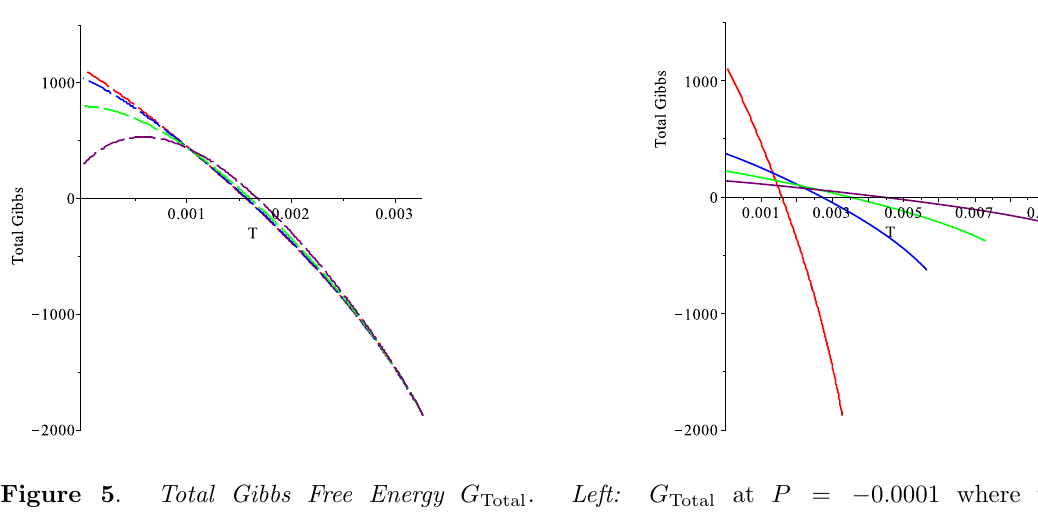
Figure 5 . Total Gibbs Free Energy G Total . Left: G Total at P = (cid:0) 0 : 0001 where the f red; blue; green; purple g curves correspond to the potential (cid:8) = f 0 : 1 ; 1 ; 2 ; 3 g respectively . Right: G Total at (cid:8) = 0 : 1 where the f red; blue; green; purple g curves correspond to the pressure P = f(cid:0) 0 : 0001 ; (cid:0) 0 : 0003 ; (cid:0) 0 : 0005 ; (cid:0) 0 : 0008 g